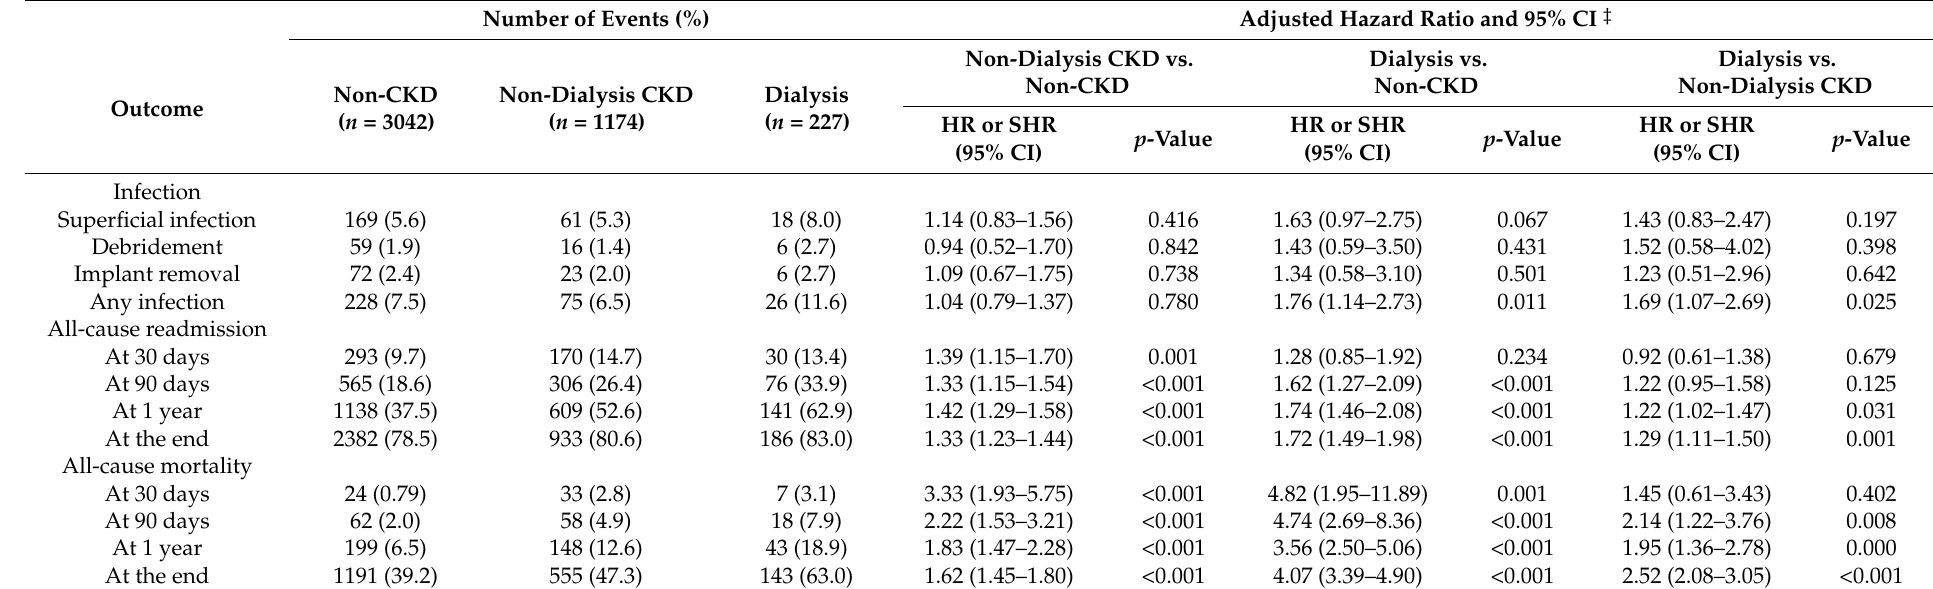
Table 3. Late outcomes of diabetic patients with shoulder arthroplasty according to renal function